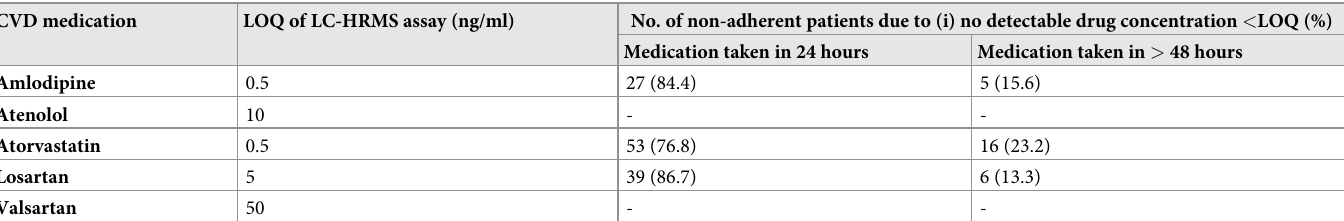
Table 5. Breakdown of non-adherent patients due to no detectable CVD drug concentration < LOQ of LC-HRMS-based dried blood spot bioanalytical assay. CVD